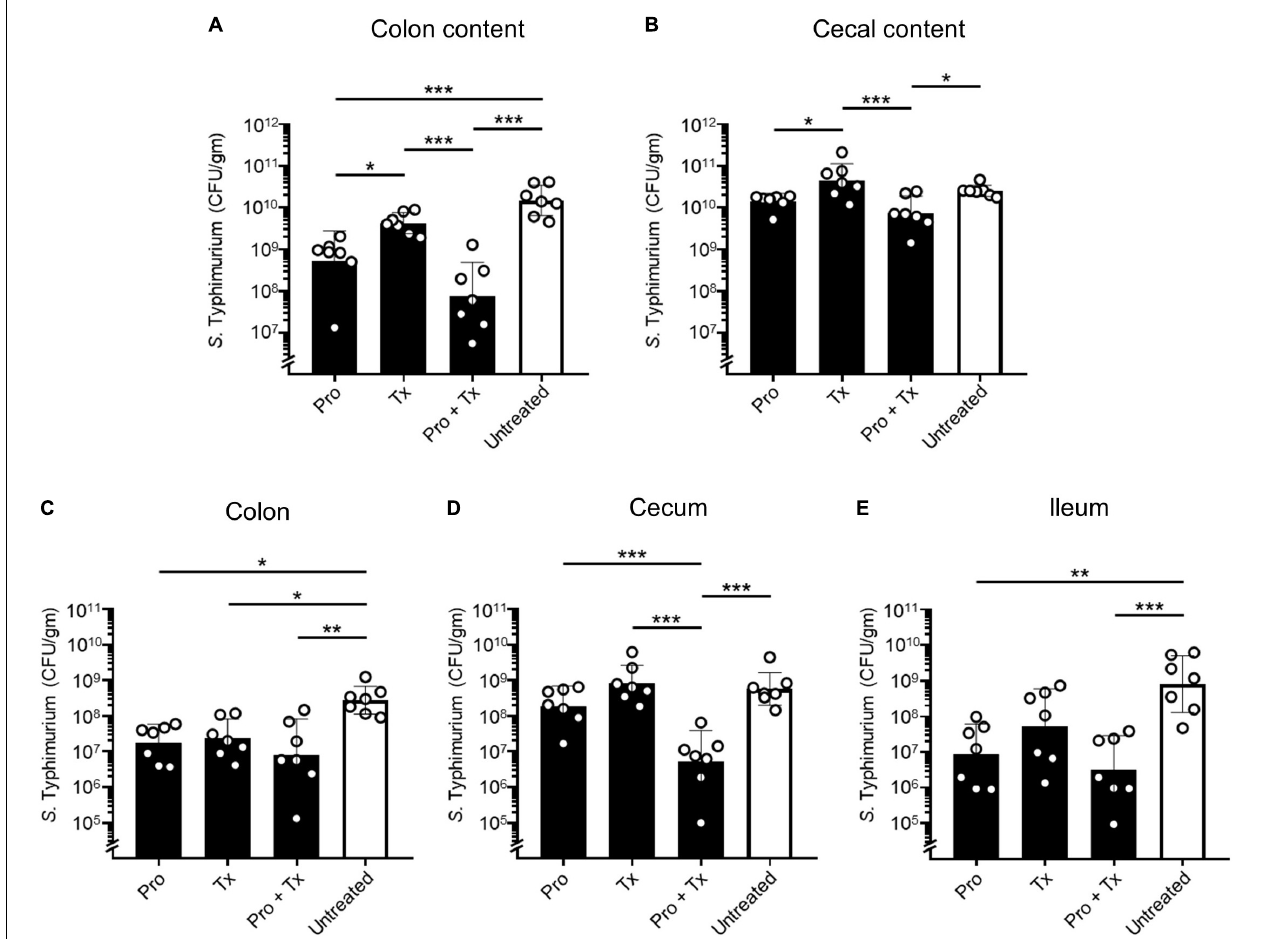
FIGURE 2 | Anti- Salmonella effect of probiotic L. reuteri KUB-AC5 in mouse inflamed gut. Female C57BL/6 mice were fed daily with 10 9 cfu AC5 in prophylactic (Pro), therapeutic (Tx), and combined (Pro + Tx) approaches for 7, 4, and 11 days, respectively (black bar). Mice in the untreated control group were fed with phosphate-buffered saline (PBS) (white bar). Then, mouse tissues were harvested at day 4 post infection and homogenized for the enumeration of STM cfu/gm tissues. Bars represent geometric means ± SD. * P < 0.05, ** P < 0.01, and *** P < 0.001 compared to all other